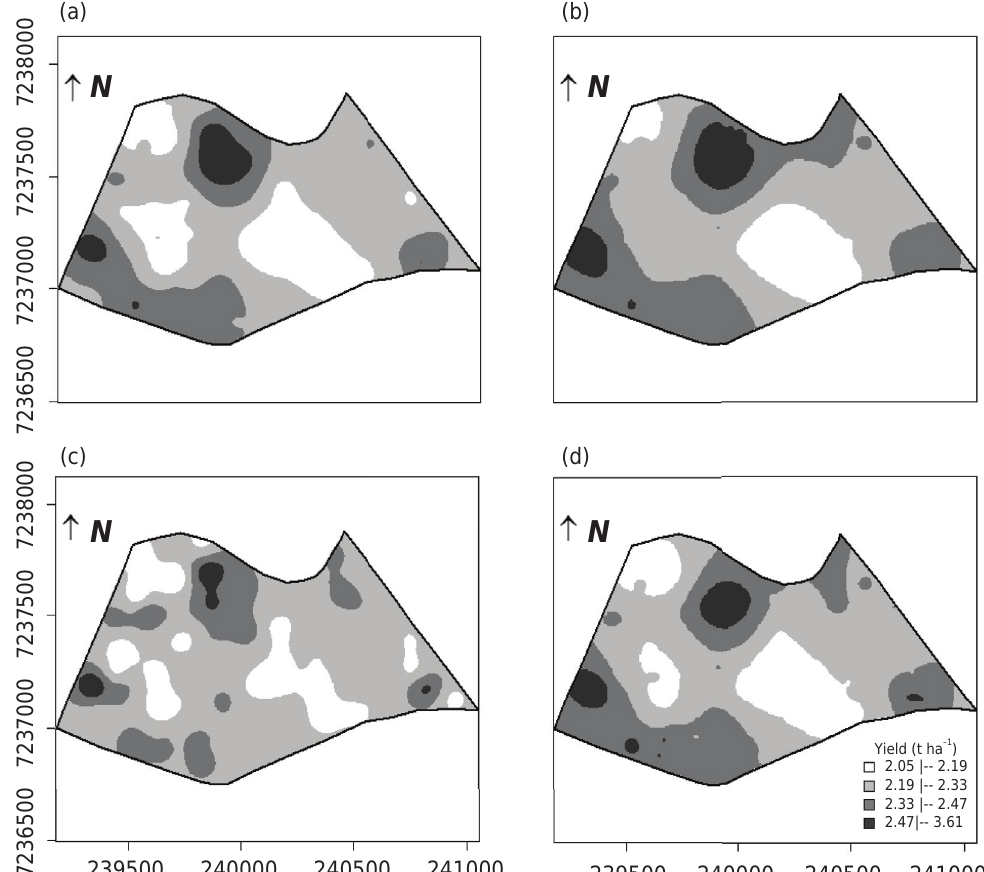
Figure 5. Interpolation maps showing the soybean yield (t ha –1 ) as a function of soil chemical properties [P, K, pH, and OM] for: (a) S 1 : Gaussian spatial linear model (GSLM) with the complete dataset; (b) S 2 : slash spatial linear model (SSLM) with the complete dataset; (c) S 3 : Gaussian spatial linear model (GSLM) removing samples 15 and 72; (d) S 3 : slash spatial linear model (SSLM) removing samples 1 and 71. Table 5. Index of similarity between the maps after local influence analysis Maps